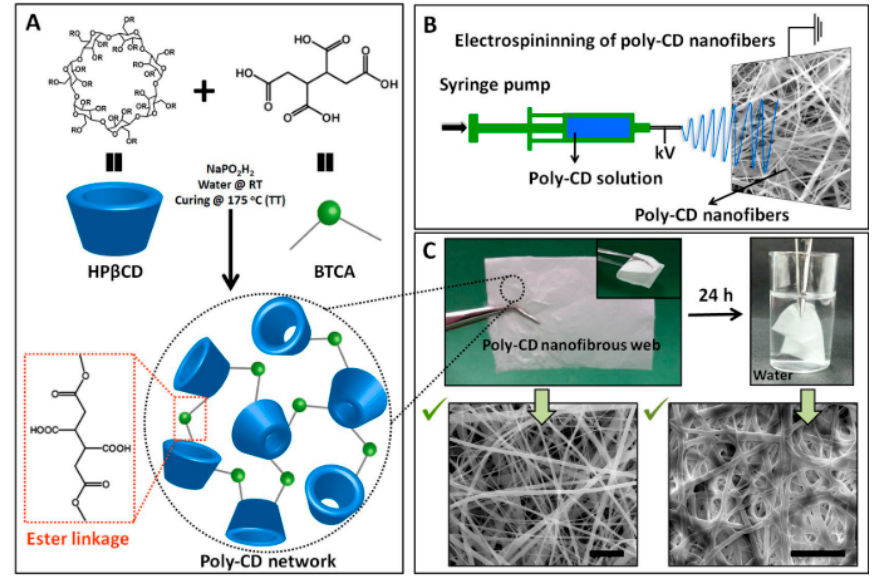
Figure 8. ( A ) Fabrication of a cross-linked poly-CD network structure from HP β CD and BTCA. ( B ) Electrospinning of the CD solutions containing BTCA and an initiator. ( C ) Digital photos of the self-standing and insoluble properties of the poly-CD nanofibrous membranes. The SEM images show poly-CD nanofibers before and after immersing in water for 24 h (scale bar: 10 µ m) (Reproduced with permission from [64]. Copyright Springer Nature, 2017.).